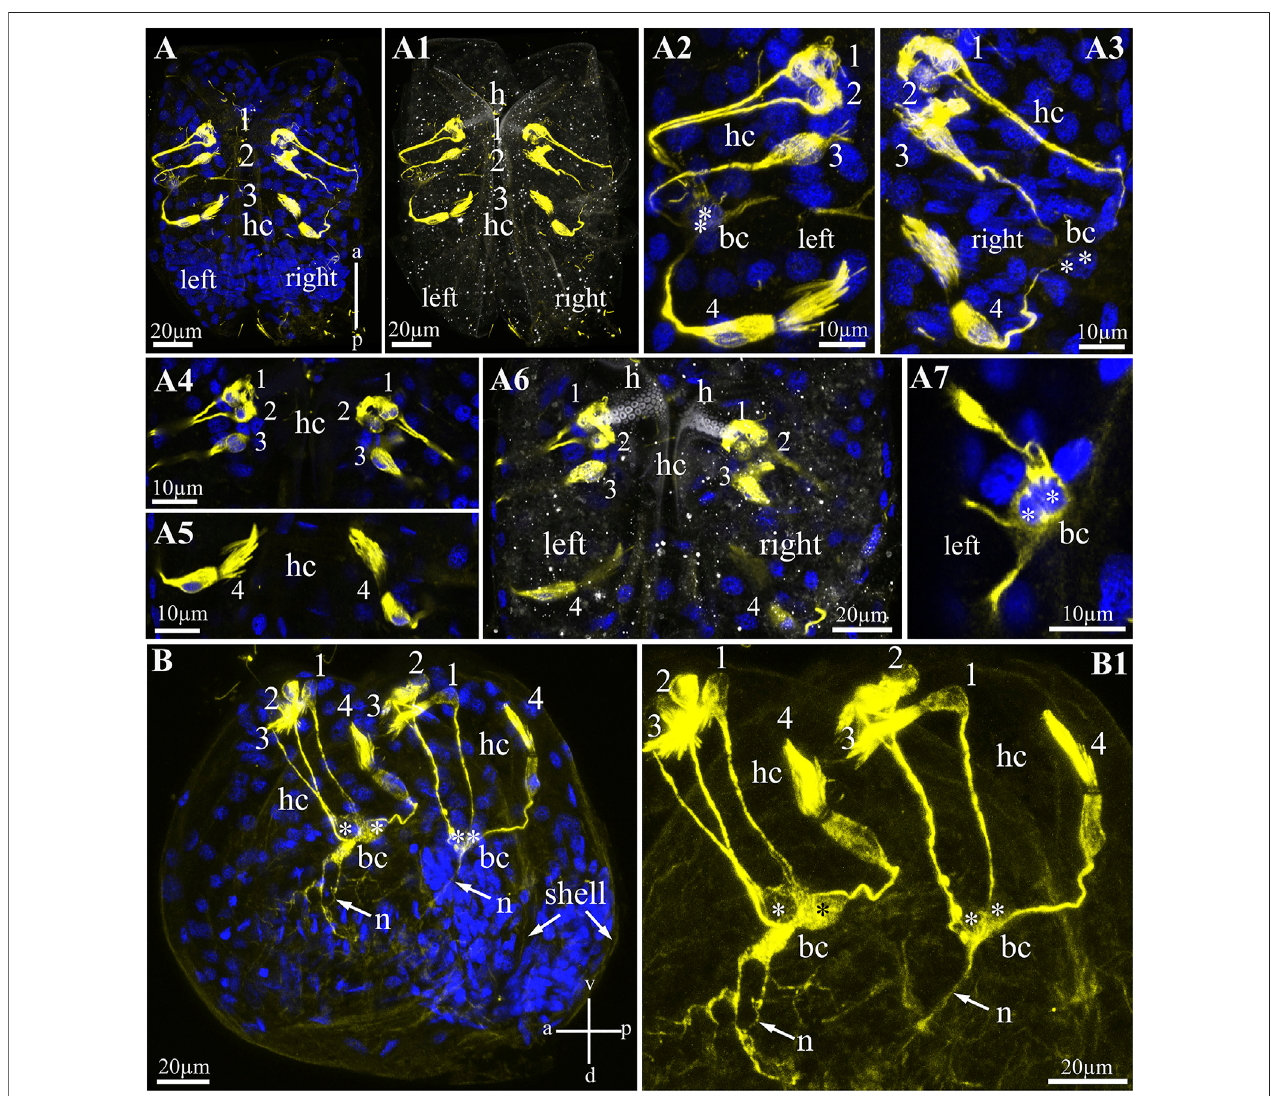
FIGURE 4 | Hair cells in glochidia of Nodularia douglasiae . (A) Whole-mount larva immunostained with anti-acetylated tubulin (yellow) antibody and DAPI (blue). Posterior view. (A1) The same larva in transmitted light and tubulin. (A2,A3) Higher magni fi cation of tubulin-lir hair cells (left, A2 and right, A3). (A4,A5) Inset of hair cells separately a bundle of three cells (A4) and a separately lying hair cell (A5) ; (A6) separate Z-stack showing the position of the hair cells relative to the larval hook; (A7) tubulin-lir basal cells; vertical a-p labelled line refers to anterior-posterior body axes. (B,B1) whole-mount larva, lateral view; (B) larva stained by tubulin with DAPI; (B1) larva stained only by tubulin. Vertical v-d labelled line refers to ventro-dorsal body axes and horizontal line a-p labelled line refers to anterior-posterior body axes of larva. Abbreviations: bc, basal cells; h, hook; hc, hair cells; n, neurites. Scale bars, (A,A1,A6,B,B1) , 20 μ m; (A2 – A5,A7) , 10 μ m.